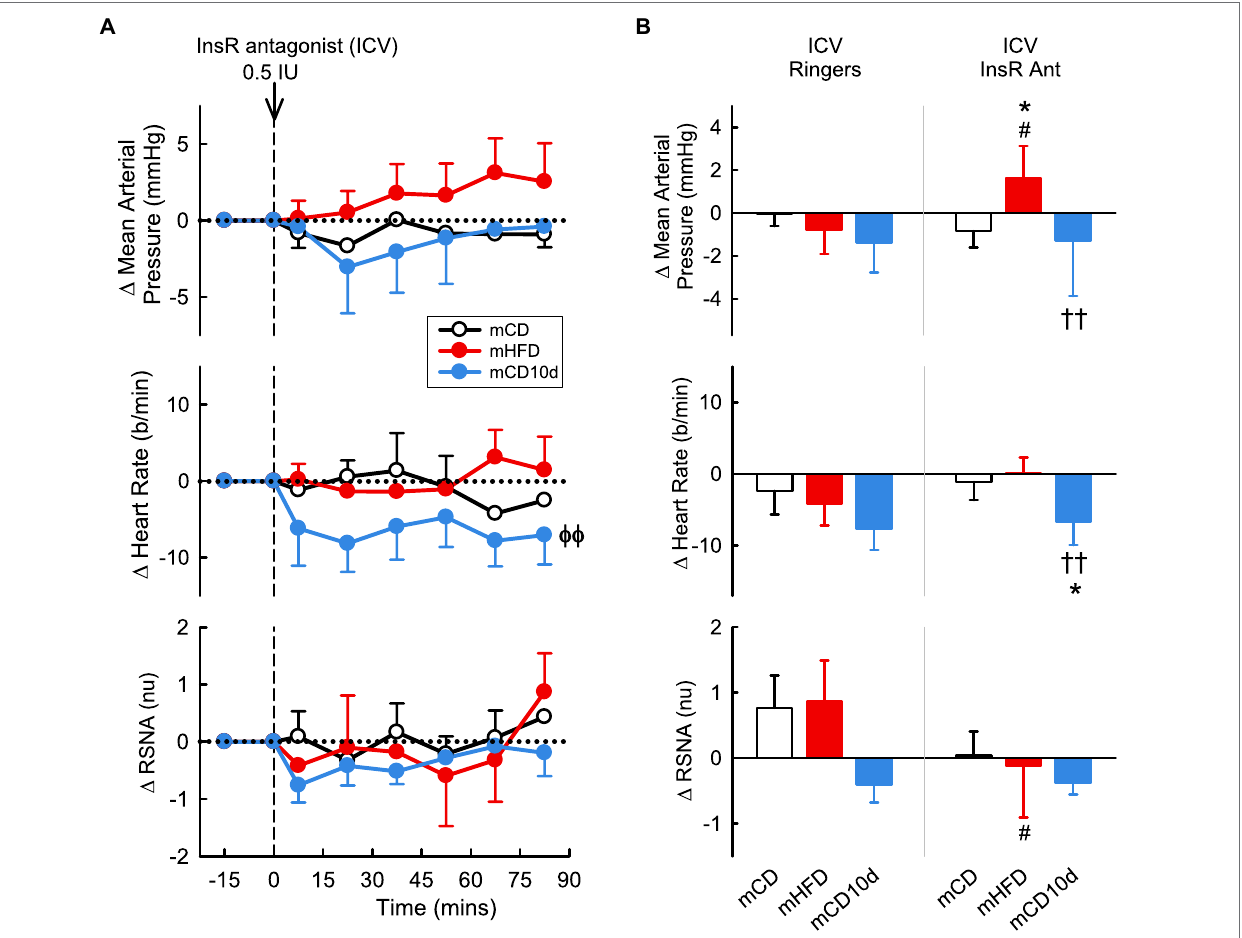
FIGURE 10 | Effects of insulin-receptor (InsR) antagonist injected ICV. (A) Average changes in MAP, heart rate, and RSNA (normalized units) from control in each group after ICV injection of InsR antagonist (0.5 IU, shown at dashed line) in mCD (white, n = 6), mHFD (red, n = 9), and mCD10d (blue, n = 6) rabbits. Data are mean difference ± SED. ϕϕ p < 0.05 for average effect of InsR antagonist. (B) Changes from control after administration of vehicle Ringer’s and InsR antagonist, averaged over all data points, given ICV in mCD, mHFD, and mCD10d rabbits. Data are mean difference ± SED from the control period of each treatment group. * p < 0.05 for comparison to mCD; †† p < 0.01 for mHFD vs. mCD10d; and # p < 0.05 for effect of InsR antagonist vs.